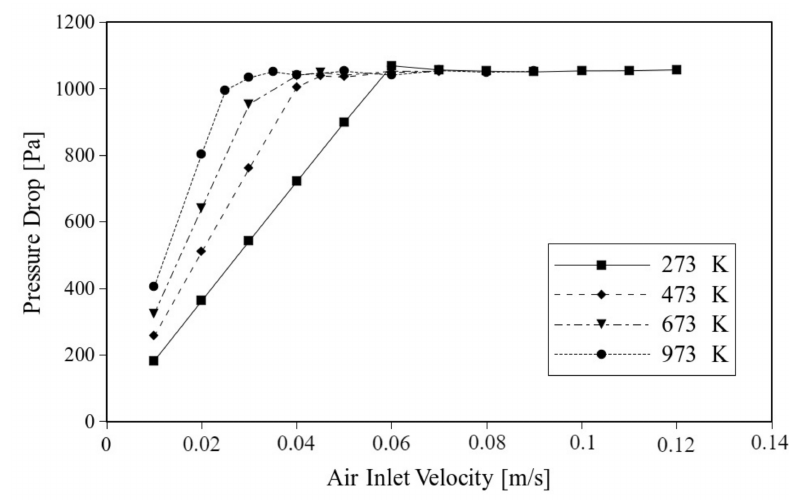
Figure 1. Fluidization curves predicted by MFiX at different temperatures.